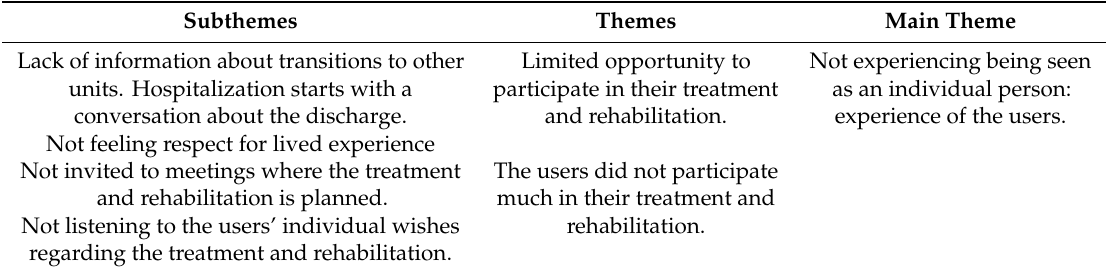
Table 5. Intersectoral care as perceived by users: subthemes, themes, and main